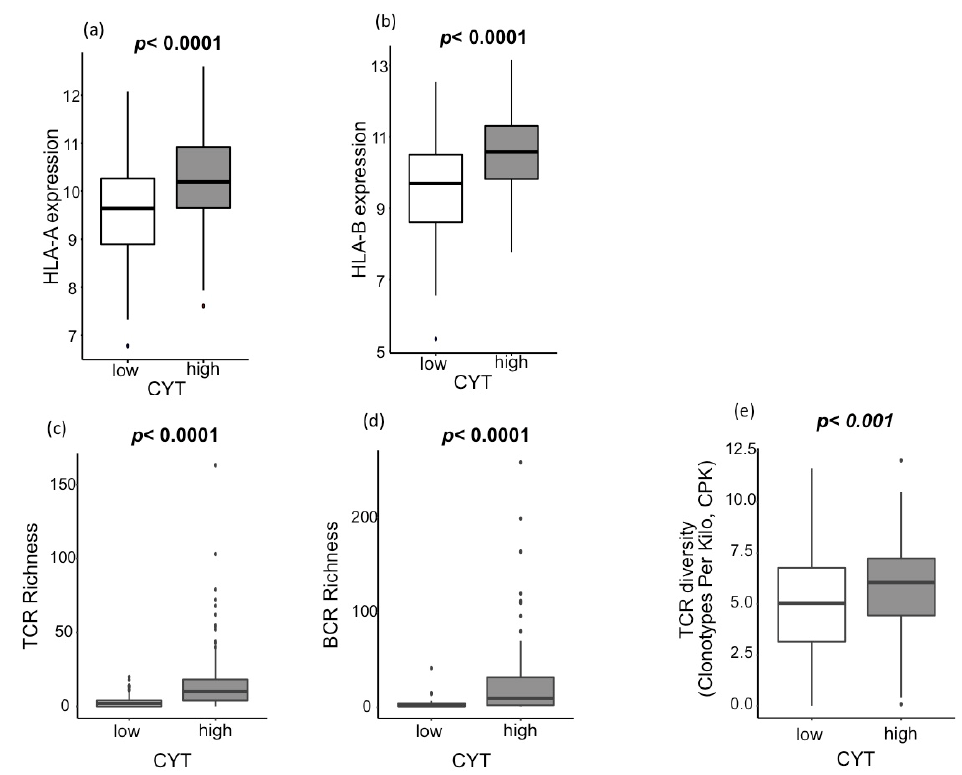
Figure 3. Association between the CYT and tumor-infiltrating lymphocyte receptor genetic diversity ( a , b ) Association between the CYT and human leucocyte antigen (HLA) expression. ( a ) Association between the CYT and HLA-A expression ( p < 0.0001), and ( b ) association between the CYT and HLA-B expression ( p < 0.0001). ( c – e ) Association between the CYT and lymphocyte receptor genetic diversity. ( c ) Association between the CYT and TCR richness ( p < 0.0001), ( d ) association between the CYT and BCR richness ( p < 0.0001), and ( e ) association between the CYT and TCR diversity ( p < 0.001). CYT-high patients were 185 patients, and CYT-low were 186 patients. All comparisons were performed using the Mann-Whitney test. CYT, cytolytic activity score; TCR, T-cell receptor; BCR, B-cell receptor; and CPK, clonotypes per